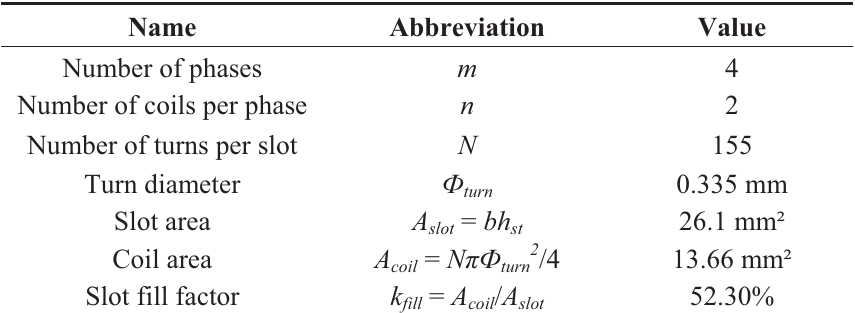
Table 2. Winding characteristics.